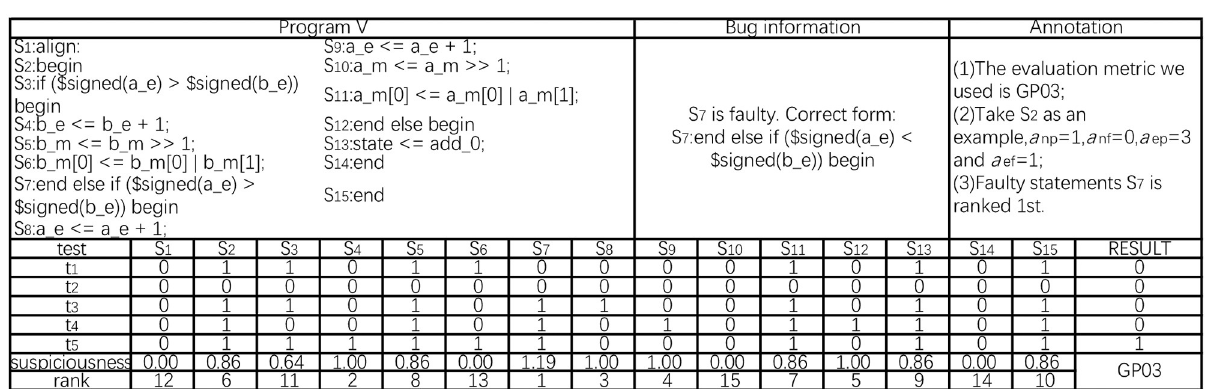
Fig 3. The lower case illustrating seven evaluation metrics of fault localization approaches. The figure content is divided into upper and lower parts. The upper part includes the program, injected fault information, and annotation. The lower part is the matrix information based on Fig 2 composed of statements and test cases, S1 to S15 are executable statements of the program, and t1 to t5 are test cases.